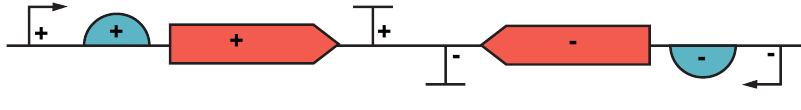
Figure 11: Example construct incorporating both inline (+) and reverse complement (-)